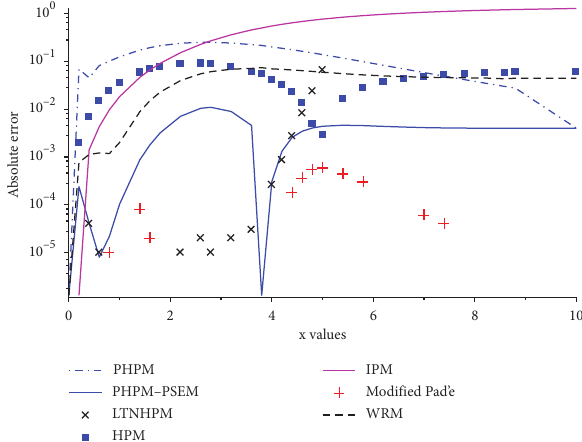
Figure 1: Absolute errors committed by using the PHPM (50) with coefficients (52), PHPM-PSEM (56) with coefficients ((54) and (57)), and other approximations from the literature for the pro- posed